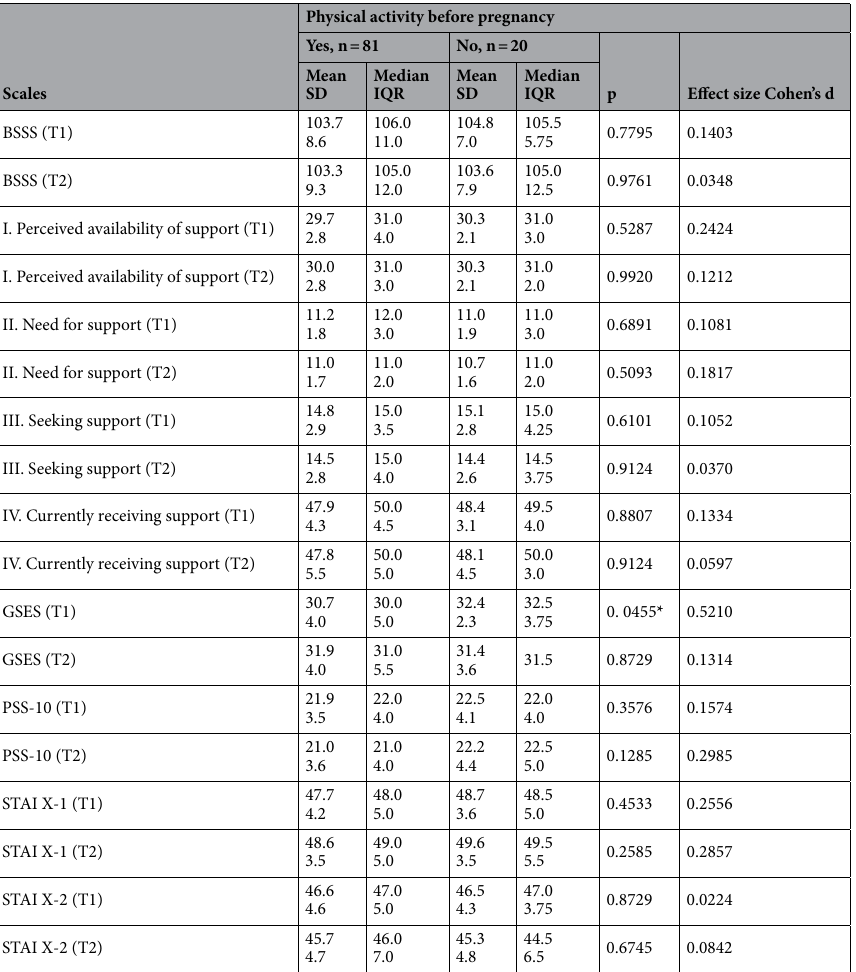
Table 4. The results of the BSSS, GSES, PSS-10 and STAI in physically active and physically inactive group of women before pregnancy (Mann–Whitney U test). BSSS, Berlin Social Support Scales; GSES, General Self Efficacy Scale; PSS-10, Perceived Stress Scale; STAI X-1, The State-Trait Anxiety Inventory as a state; STAI X-2, The State-Trait Anxiety Inventory as a trait;T1, Initial results; T2, Final results; *p <